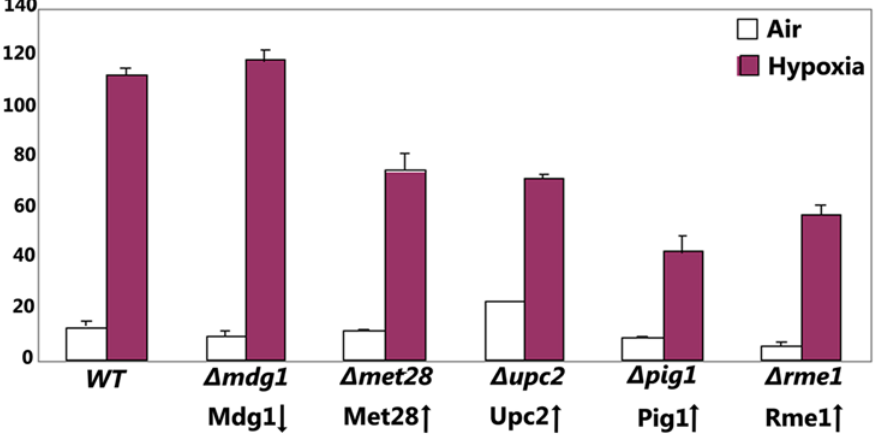
Figure 7. Experimental confirmation of the oxygen regulators identified by MEDUSA. MEDUSA identified Mdg1, Met28, Upc2, Pig1 and Rme1 as specific regulators of the hypoxia-inducible OLE1 gene. To detect the effects of these regulators on the OLE1 gene, the full-length OLE1 promoter -lacZ reporter [39] was transformed into the wild type or mutant cells with one of the indicated genes deleted. b -galactosidase activities were measured in cells grown in air or in hypoxic chamber. Data plotted here are averages from at least three independent transformants. The arrows indicate the effects of hypoxia on the expression levels of Mdg1, Met28, Upc2, Pig1 and Rme1. That is, Mdg1 was downregulated whereas the rest were upregulated in hypoxic